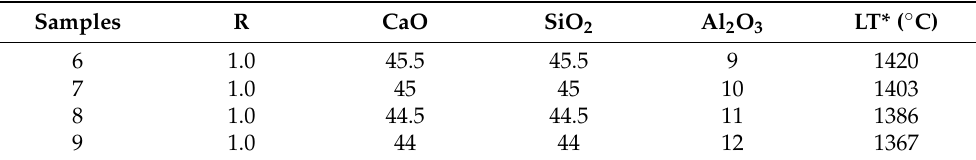
Table 2. Composition ratios of the CaO-SiO 2 -Al 2 O 3 system with different Al 2 O 3 contents (mass %).